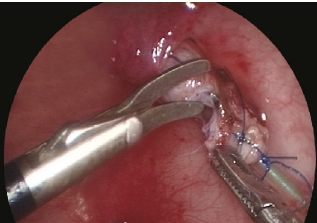
Figure 6: Ureteroneocystostomy is performed under endoscopic guidance with intracorporeal suturing using interrupted 5-0 or 6- 0 poliglecaprone or polydioxanone sutures.